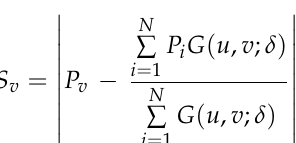
( b ) Figure 4. SIGs constructed using: ( a ) the original method and ( b ) our method. Figure 5 illustrates the rendering of surface variations with different neighborhood ranges of a small point cloud. The figure demonstrates that the different level features (granularities) are well described by the surface variations calculated by 3D Gaussian smoothing.